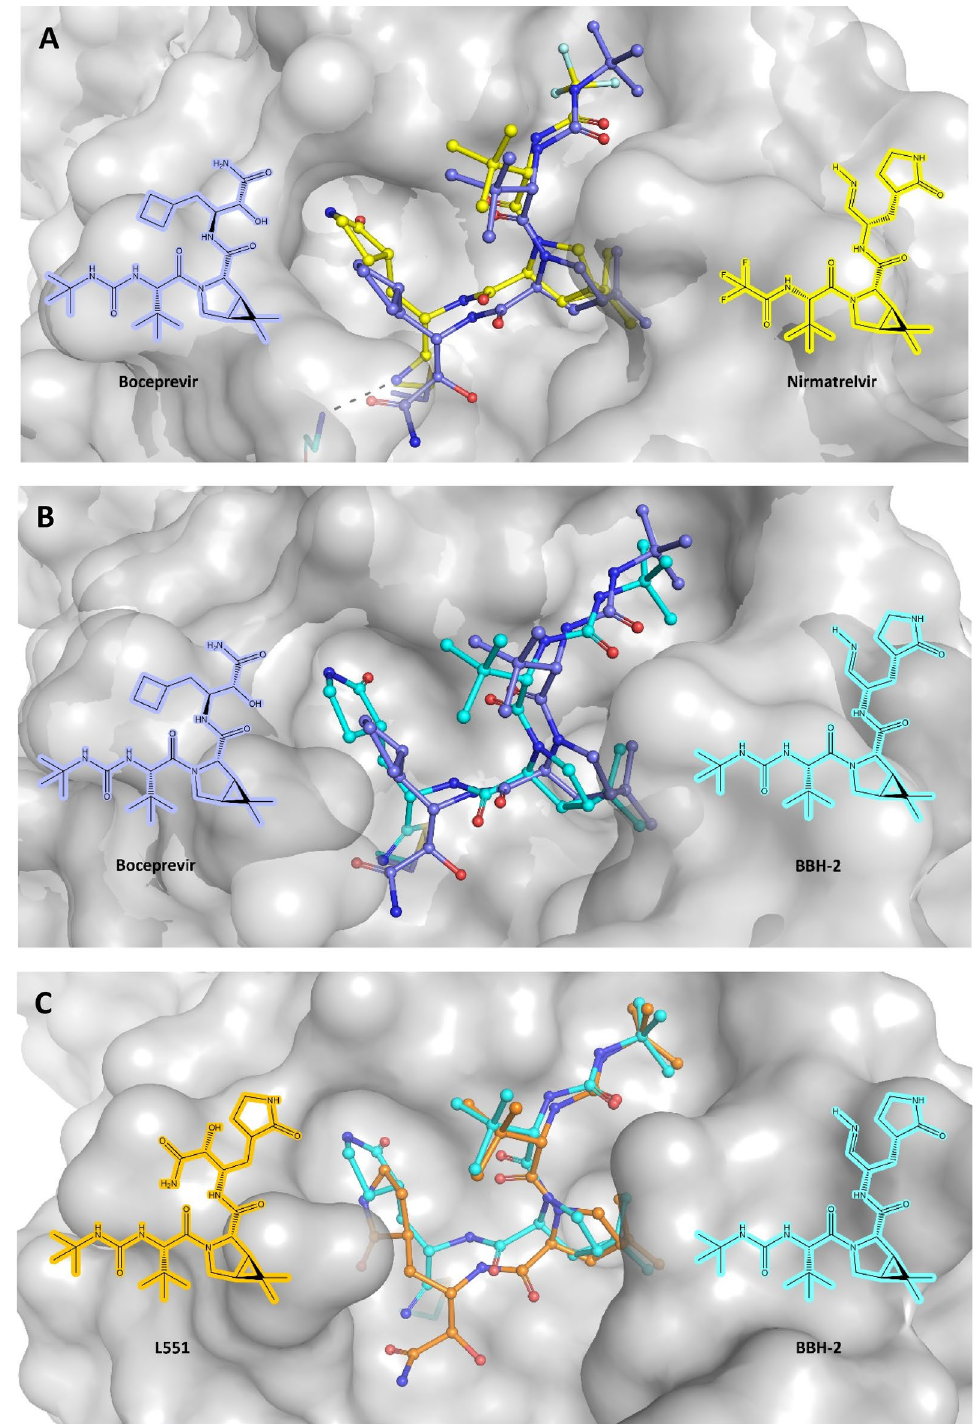
Figure 5. Comparison of the binding modes of four closely related ligands to the M pro . ( A ) Comparison of boceprevir (PDB: 7K40—this study) and nirmatrelvir 51 (PDB: 7RFW) binding modes to the M pro . The nitrile warhead of the nirmatrelvir can make a 3.0 Å hydrogen bond to the Gly143 (shown in black dotted line) ( B ) comparison of boceprevir (PDB: 7K40) and BBH-2 55 (PDB: 7TEH) binding modes to the M pro . ( C ) comparison of the designed L551 with the molecular docking binding mode as shown (Fig. S2D—this study) and the binding mode of BBH-2 (PDB: 7TEH) to the M pro . The chemical structures are shown in their binding form. Structures were drawn using ChemDraw 14 Professional from PerkinElmer (https:// perki nelme rinfo rmati cs. com/ produ cts/ resea rch/ chemd